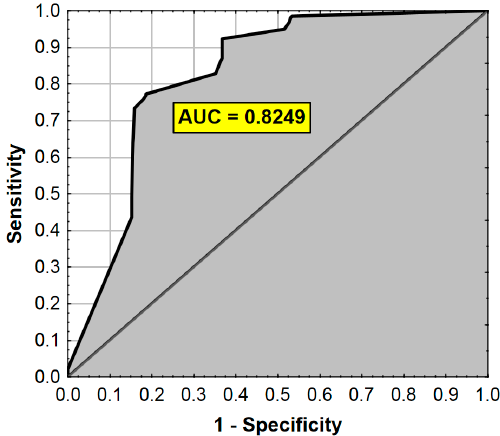
Figure 2. ROC curve and AUC value for the regression model from Table 6. AUC—Area Under the Curve (measure of diagnostic accuracy).